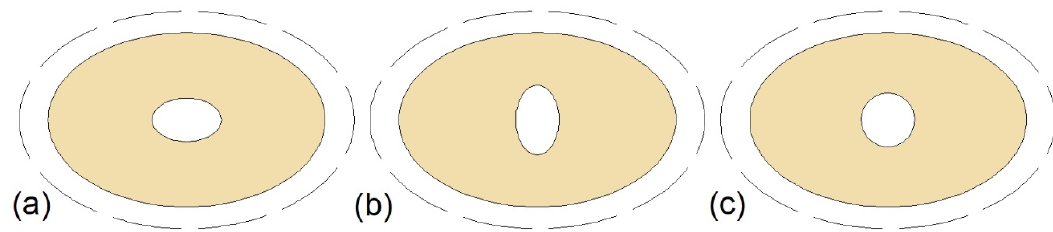
Figure 11. Triple- or triplex-tube heat exchangers (TTHXs) with: ( a ) Horizontal ellipse inner tube; ( b ) vertical ellipse inner tube; ( c ) circular inner tube [77].